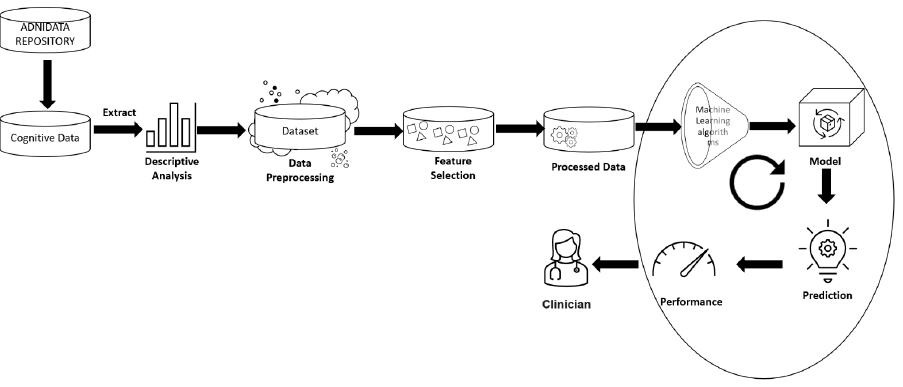
Figure 1. Data process